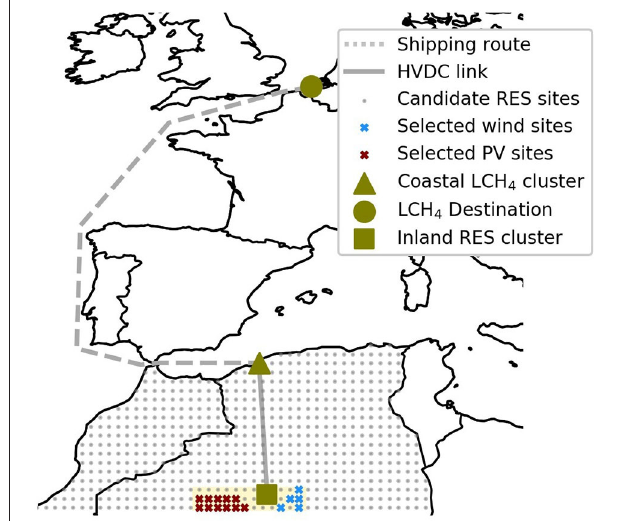
FIGURE 2 | Remote carbon-neutral methane supply chain: electricity is produced in a remote inland cluster in central Algeria and transported to a coastal cluster where carbon-neutral methane is synthesised and liquefied for export to Northwestern European